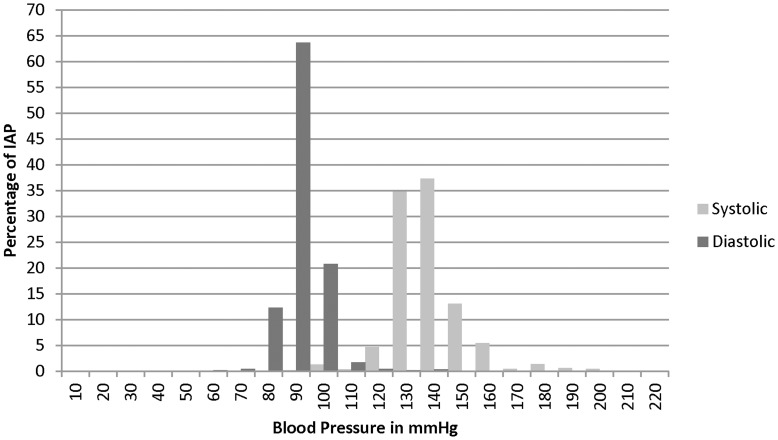
Lower Limit of Blood Pressure at which to initiate medication in <60 YO*.IAP- Informal Allopathic Practitioner, mmHg- millimeters of mercury. *Medication should typically be initiated at 140/90 mmHg.